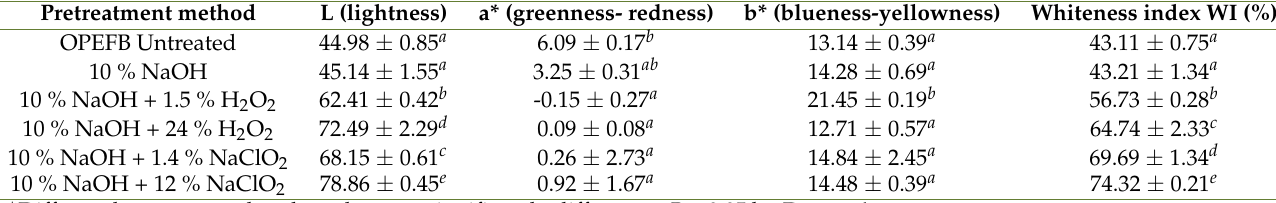
Table 3. The color analysis results and whiteness index of OPEFB before and after pretreatment process.